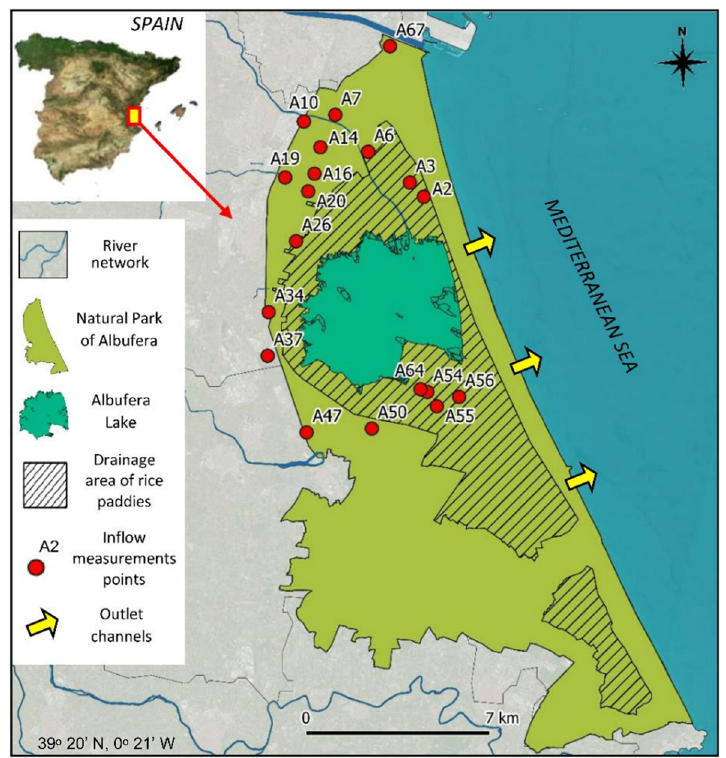
Figure 1. Study area with the limit of the Natural Park of Albufera, the area of Albufera Lake, the drainage area of rice fields (winter flooding area), the 19 points were the inflows to the lagoon was measured and the three outlet channels.